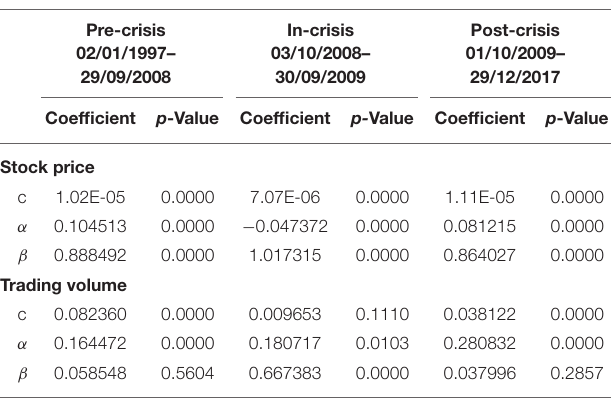
TABLE 2 | Results for variance equations.